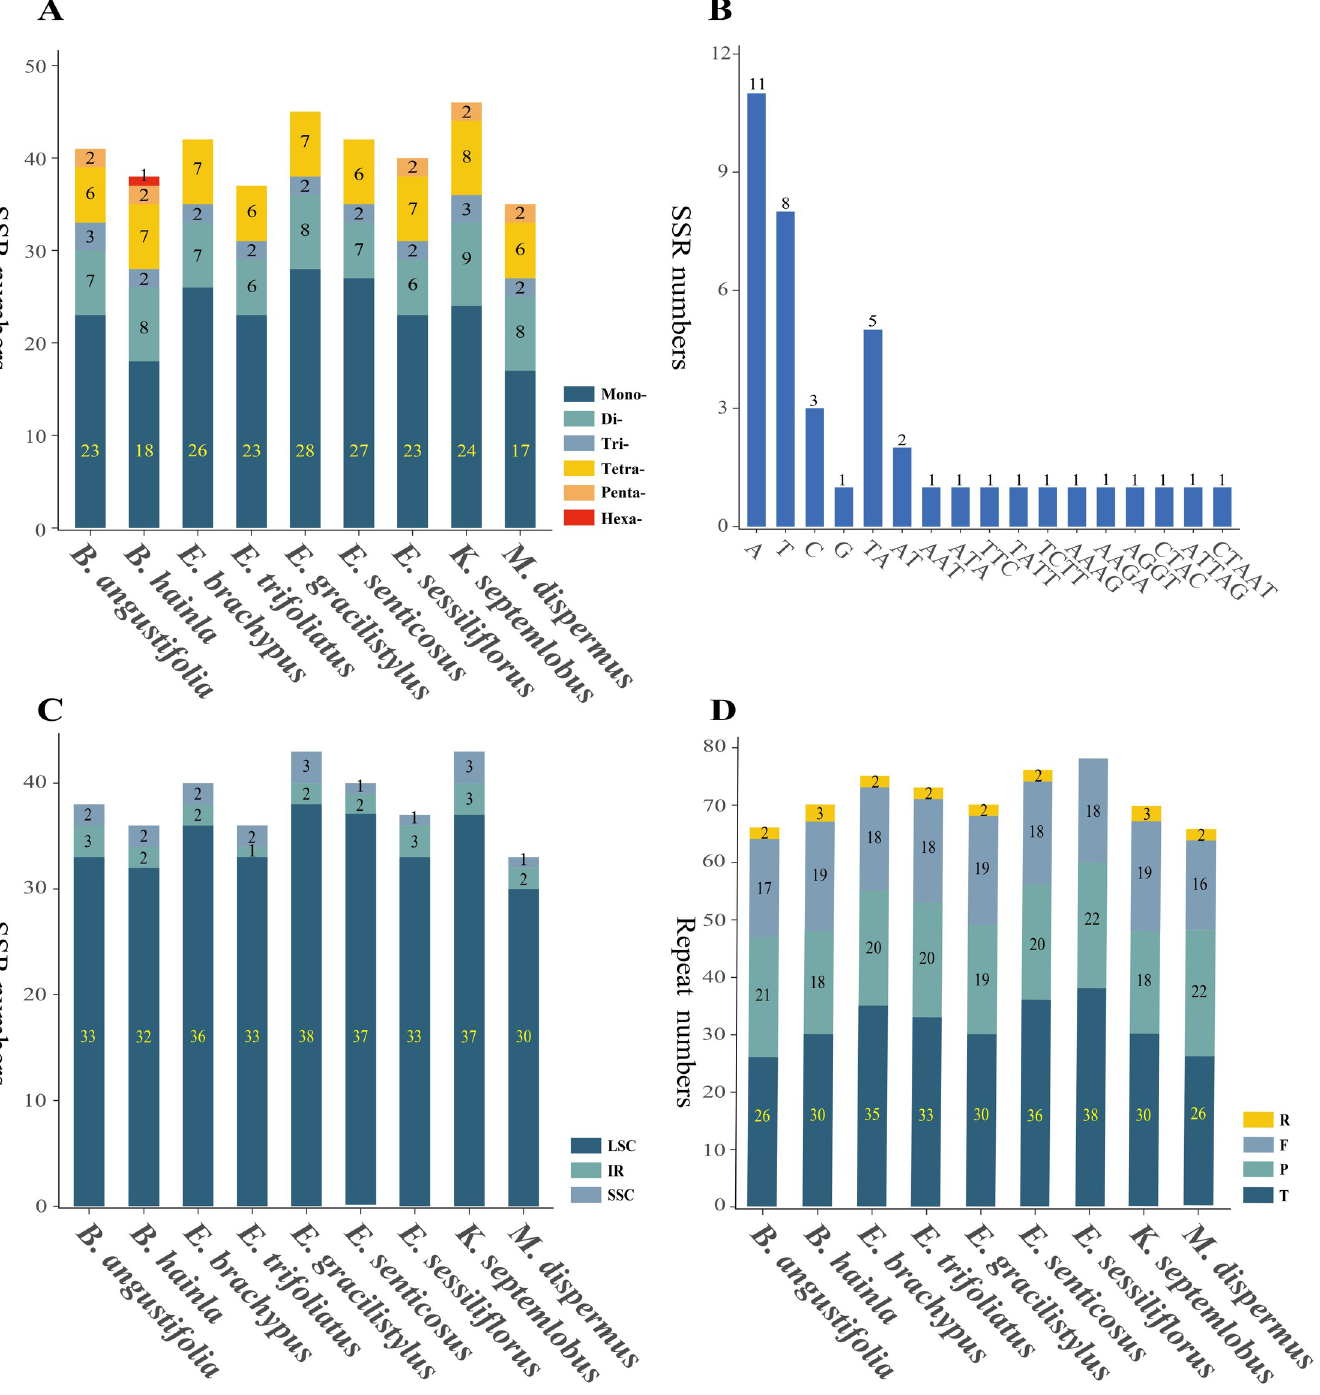
Fig 3. The simple sequence repeat (SSR) elements in the chloroplast genome of nine species in the Asian Palmate group. (A) Number of six SSR types. (B) Number of identified SSR motifs of Brassaiopsis angustifolia . (C) Frequency of identified SSRs in large single copy (LSC) regions, small single copy (SSC) regions, and inverted repeat (IR) regions. (D) Total of four repeat